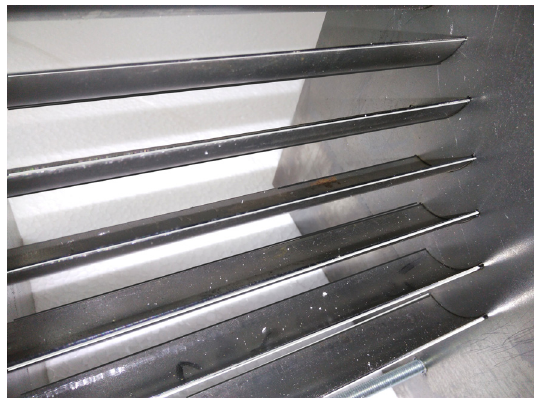
Fig. 25. The close-up photograph of the flow-turning blades (their detail is in Fig. 24) already fixed to their position in the return-flow duct.